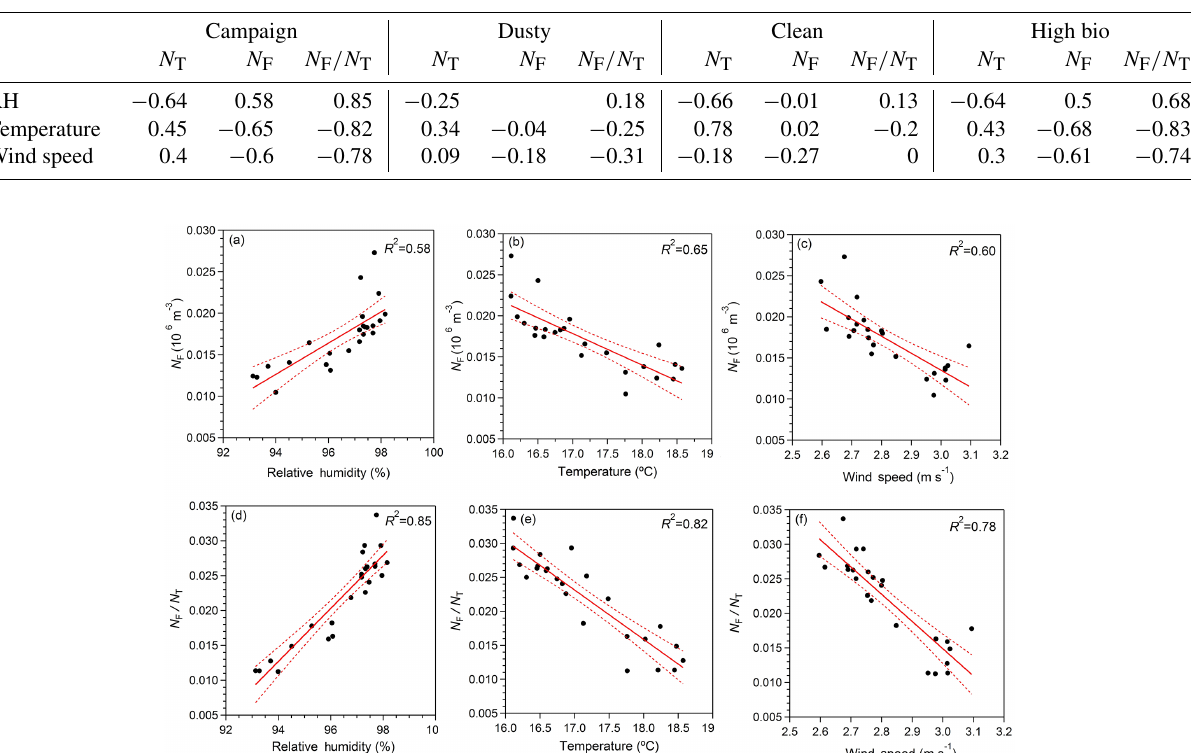
Figure 15. Correlation between aerosol particle number concentrations ( N F , N T , and N F /N T ) and meteorological parameters (relative humidity, temperature, and wind speed). The red line indicates the best fit to the scattered points and the dashed black line indicates the 95% confidence level obtained for the best